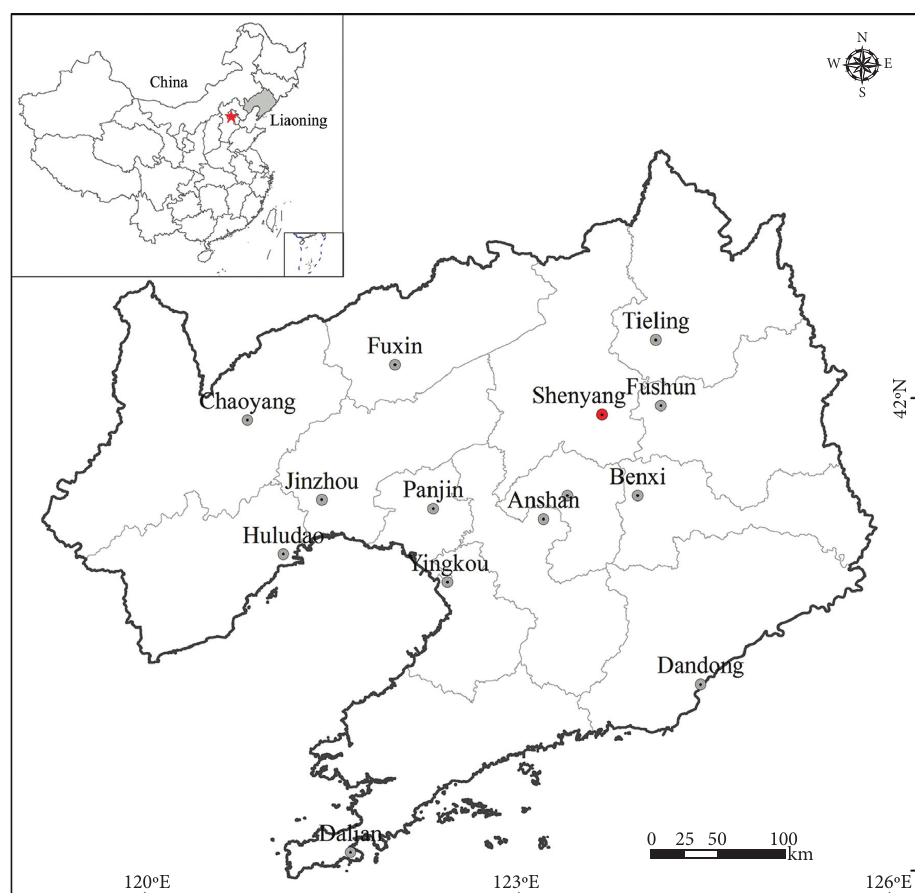
Figure 1: Location of the studied